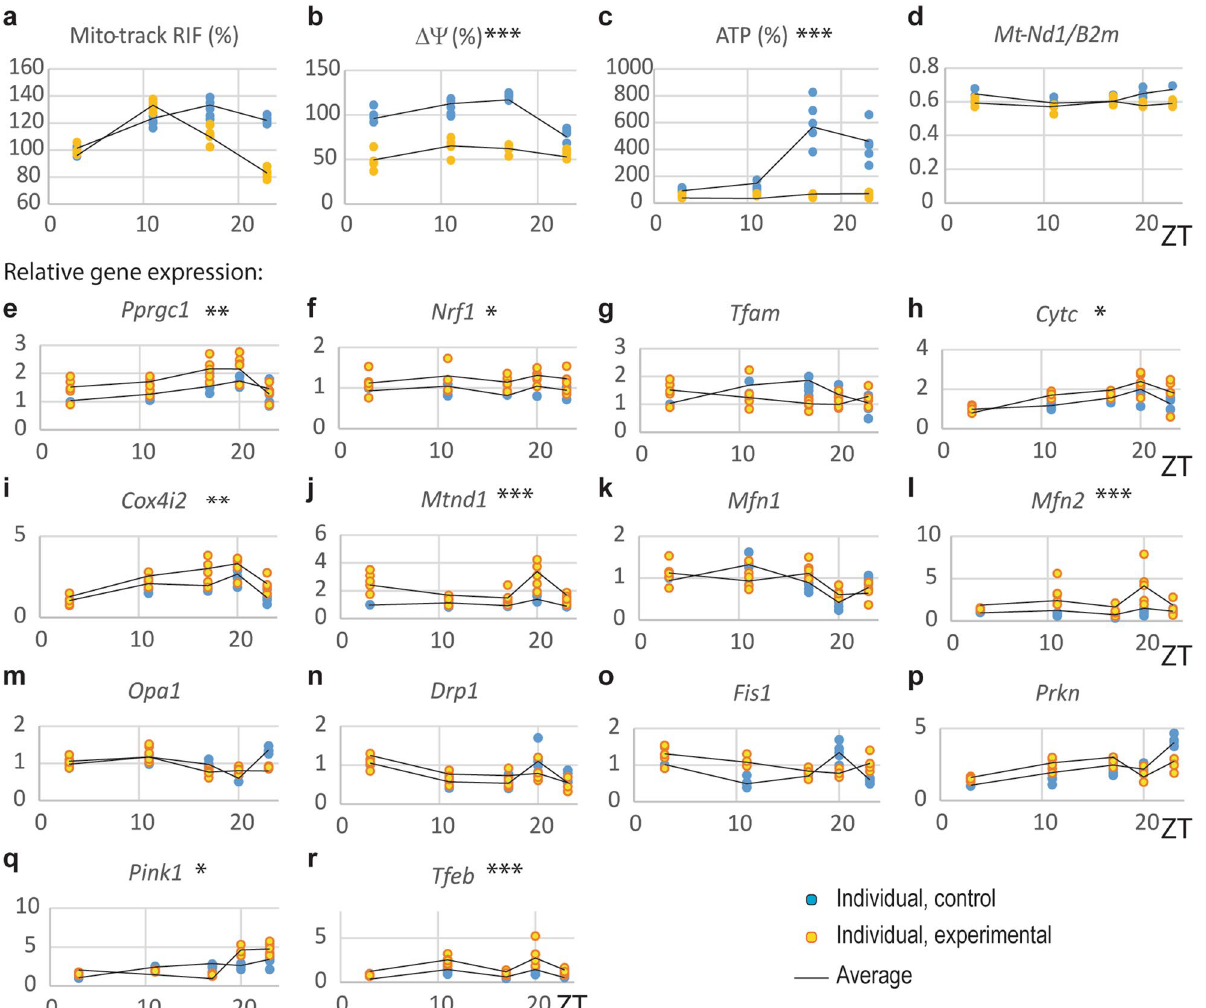
Figure 5. CD changed mitochondrial function. Leydig cells from both groups were individually isolated at different time points during 24 h and followed by measurements to estimate mitochondrial mass and function: mitochondrial mass was estimated through mitotrack assay ( a ) and Mt-Nd1 / B2m ratio ( d ), mitochondrial membrane potential (ΔΨ) was estimated through TMRE measurement ( b ) and mitochondrial energetic function was estimate through ATP measurement ( c ). CD decreased mesor of ΔΨ and ATP production. Mitochondrial biogenesis were estimated by transcriptional activity for several genes ( e – j ); mitochondrial fusion ( k – m ); mitochondrial fission ( n , o ) and mitophagy ( p – r ). Statistical significance: *p < 0.05; **p < 0.01; ***p < 0.005; ****p < 0.001 determined by two-way